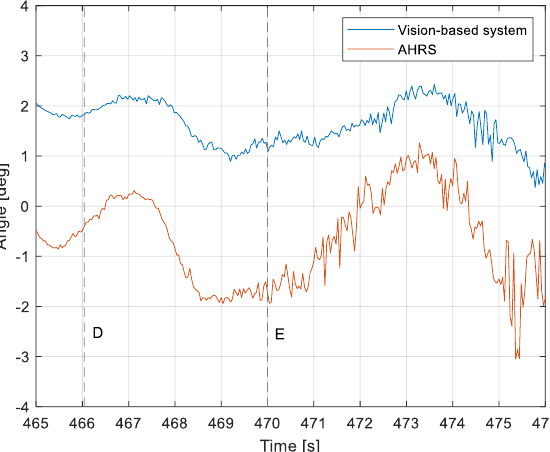
Figure 22. Angle between the longitudinal axis of the aircraft and the centerline: Flight no. 2 (markers D-E correspond to the moment of recording the images in Figure 11.